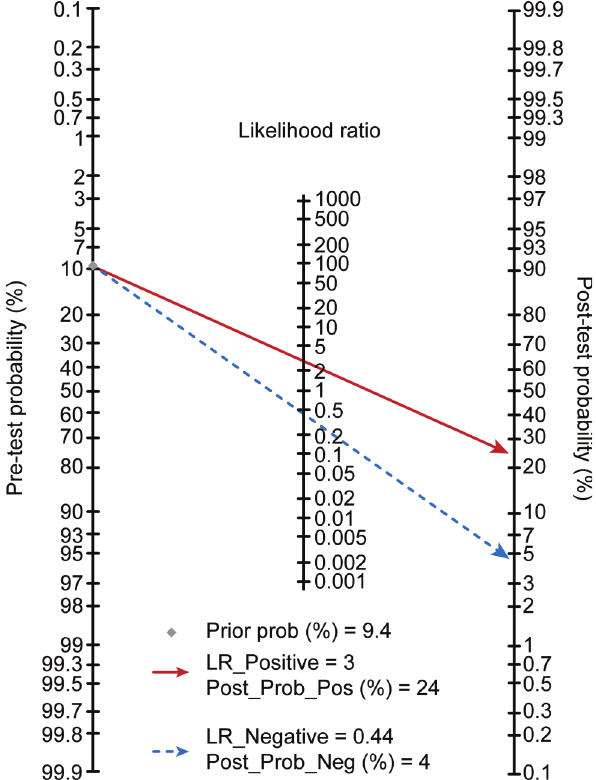
Figure 2 - Fagan plot of the LR model that was used for the prediction of hypoxemia.